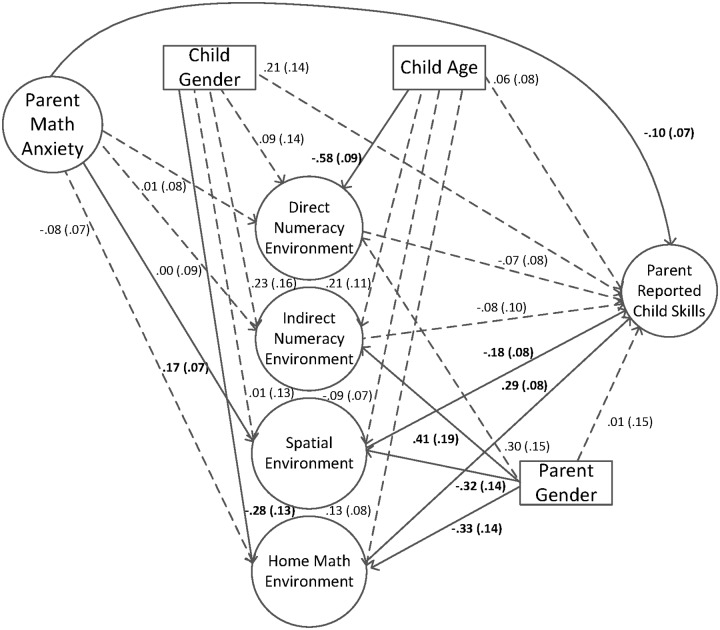
Home math environment factors and parent math anxiety predicting parent report of child skills.Standard errors are in parentheses. Solid lines and bolded text represent significant pathways, p < .05. Longdash lines represent non-significant pathways, p > .05.